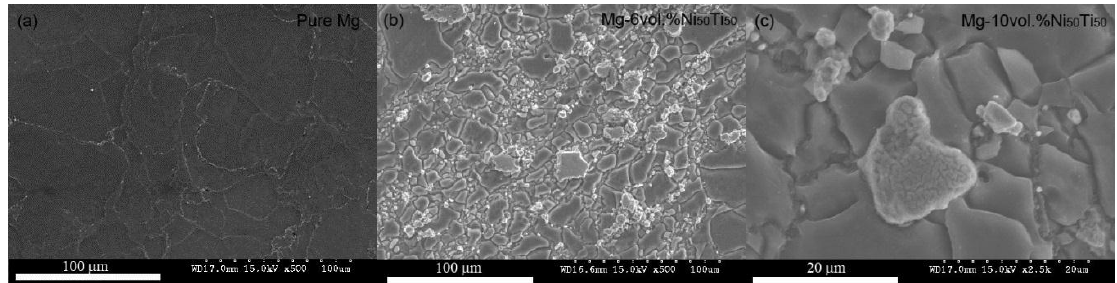
Figure 15. SEM micrographs showing the microstructural characteristics of: ( a ) pure Mg and its composite containing different amounts of Ni 50 Ti 50 amorphous reinforcement ( b , c ).